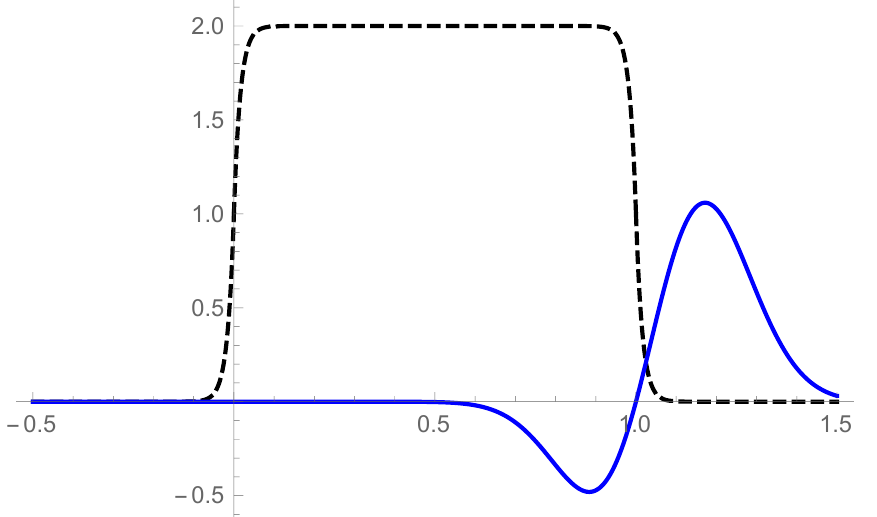
Figure 4 . Analysis of the QEI for large values of a=(cid:12) . The energy density (solid blue line) consists of a negative and positive pulse, with the positive one being suppressed by the function f (dashed black line). This tell us that the l.h.s. (3.22) will take large negative values and this is in